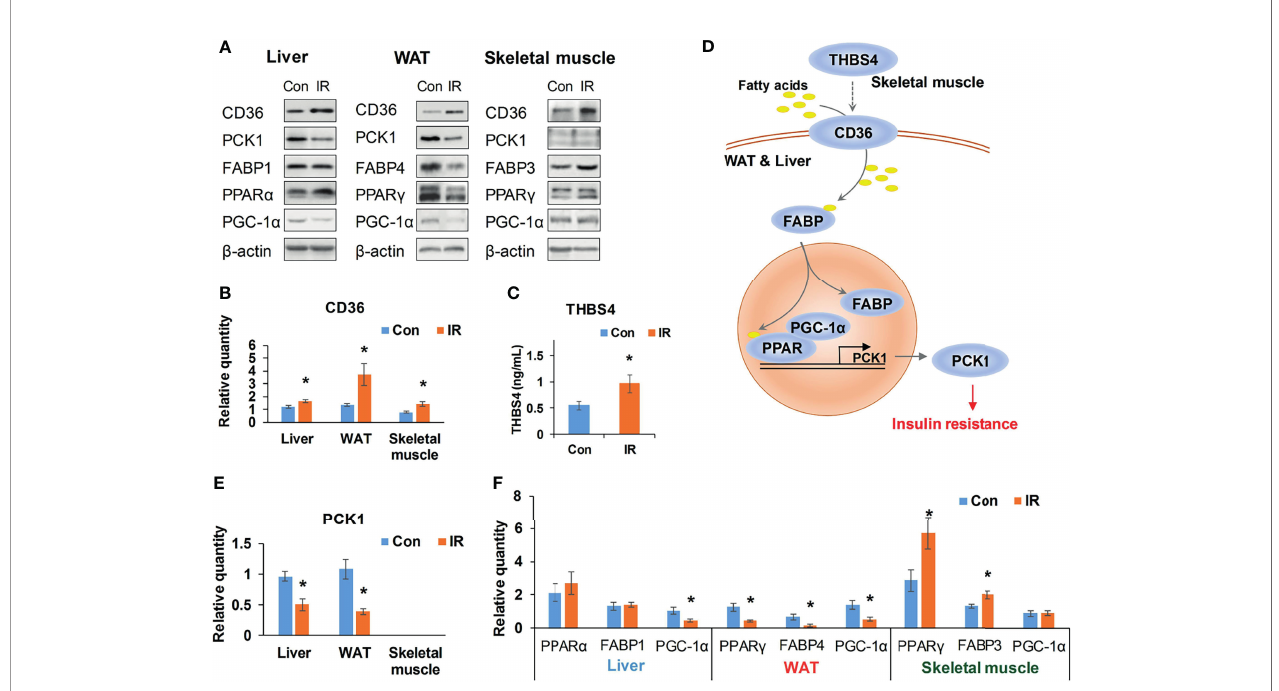
FIGURE 7 | Validation of CD36 – PPAR axis. (A) Representative WB bands of candidate proteins; (B) Relative quantity of CD36 based on WB bands (n =4/group); (C) Serum THBS4 level of experimental mice, (n = 9/group); (D) A potential cross-tissue mechanism of CD36-PPAR axis; (E) Relative quantity of PCK1 based on WB bands (n = 3 – 4); (F) Relative quantity of regulators in PPAR pathway based on WB bands (n = 4). *P < 0.05, compared to control group, Student ’ s t-test; the normality of corresponding data was determined by Shapiro – Wilk test (P >